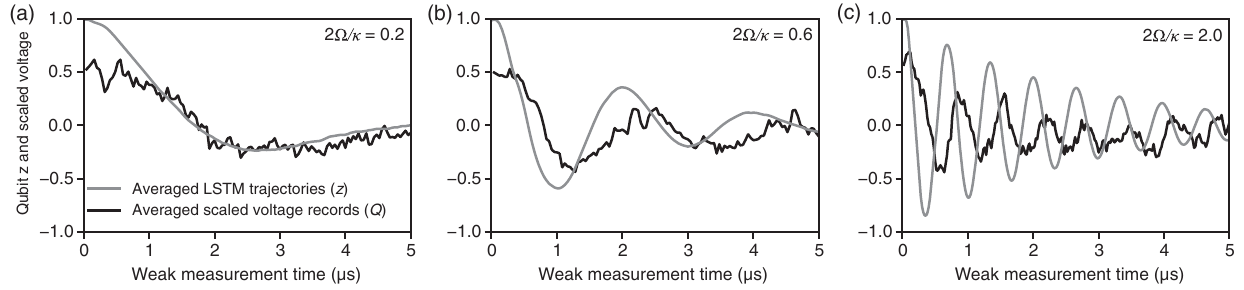
FIG. 12. Comparison between averaged voltage records and averaged z trajectories reconstructed by the LSTM for increasing Rabi frequencies: (a) 2 Ω = κ ¼ 0 . 2 , (b) 2 Ω = κ ¼ 0 . 6 , and (c) 2 Ω = κ ¼ 2 . 0 . Both the trajectories and voltage records are averaged M ¼ 5 × 10 3 times.